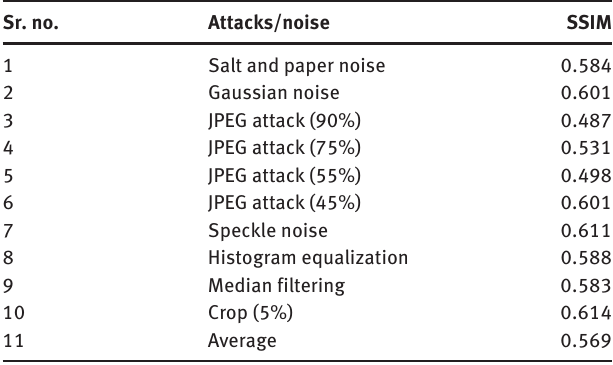
Table 3: SSIM Values of the Extracted Watermark for Different Attacks. Sr.